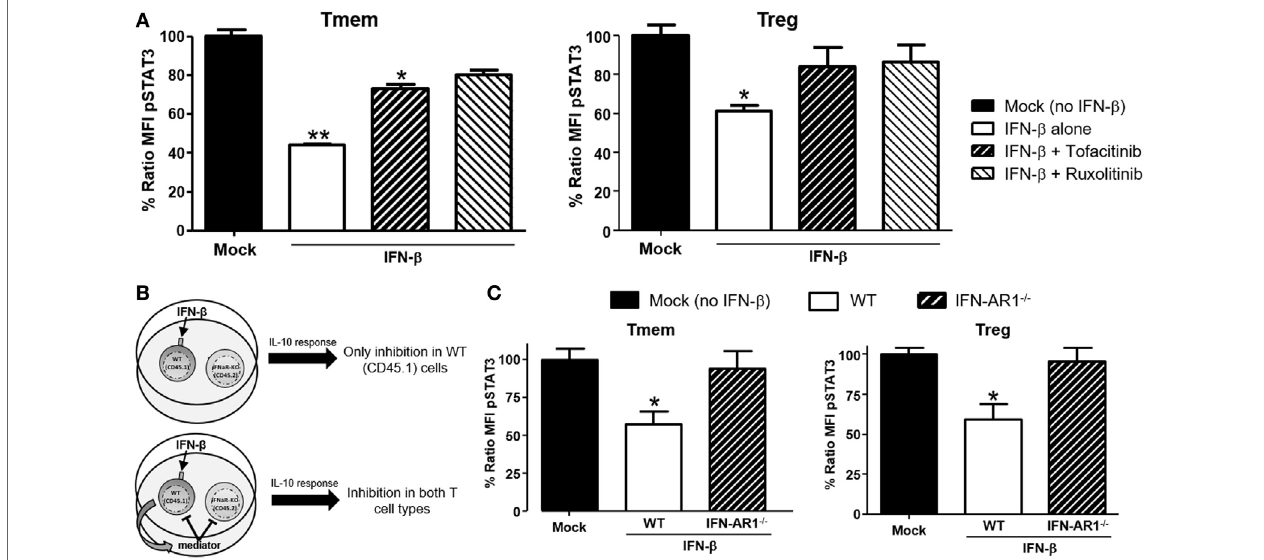
FigUre 5 | IFN- β signals through JAK–STAT pathway to directly inhibit interleukin-10 (IL-10) signaling in T cells. (a) Impact of JAK–STAT inhibition on the ability of IFN- β to modulate IL-10 signaling. T cells from C57BL/6 mice were exposed to Tofacitinib (25 µM) or Ruxolitinib (5 µM) for 2 h before addition of IFN- β and then cultured for 48 h (followed by a 6–8 h resting phase in cytokine-free media). Their ability to respond to IL-10 (40 ng/ml) was then measured by means of P-STAT3 levels assessed via Phospho-flow. (B) Schematic representation of the experimental approach adopted to assess the direct or indirect impact of IFN- β . (c) Purified T cells from congenic C57BL/6 (CD45.1) and IFN-AR1 − / − (CD45.2) mice were mixed at a 1:1 ratio. This mix was cultured for 48 h with or without IFN- β (5 ng/ml) and then rested in cytokine-free media for additional 6 h. The response to IL-10 of each subpopulation was then assessed via Phospho-flow. Data of n = 3 individual experiments are shown and expressed as % of ratio mean fluorescence intensity (MFI) ± SEM, * p < 0.05, ** p ≤ 0.01, paired Student’s t